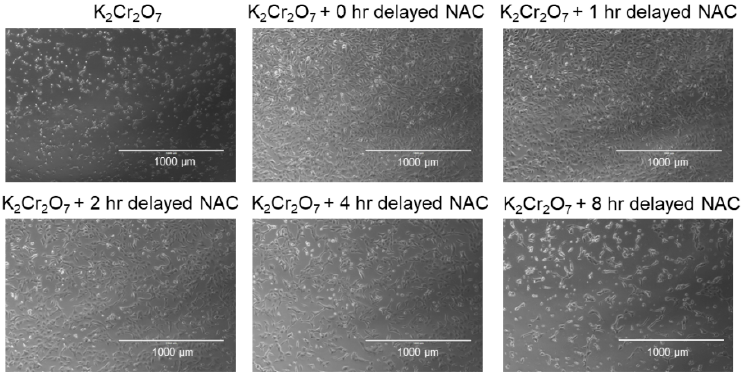
Figure 4. Morphology of HK-2 cells. ( A ) 10 μ M K 2 Cr 2 O 7 -treated HK-2 cells and 10 μ M K 2 Cr 2 O 7 -treated HK-2 cells with delayed NAC treatment at ( B ) 0 h, ( C ) 1 h, ( D ) 2 h, ( E ) 4 h, and ( F ) 8 h.